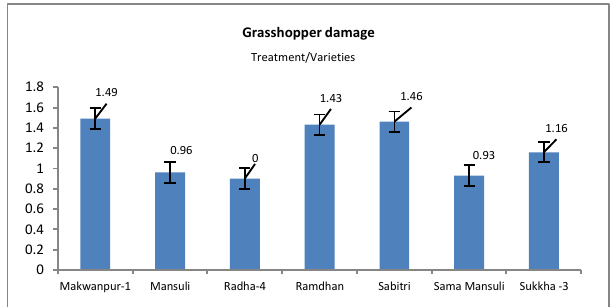
Figure 2: Average grasshopper damage in different rice